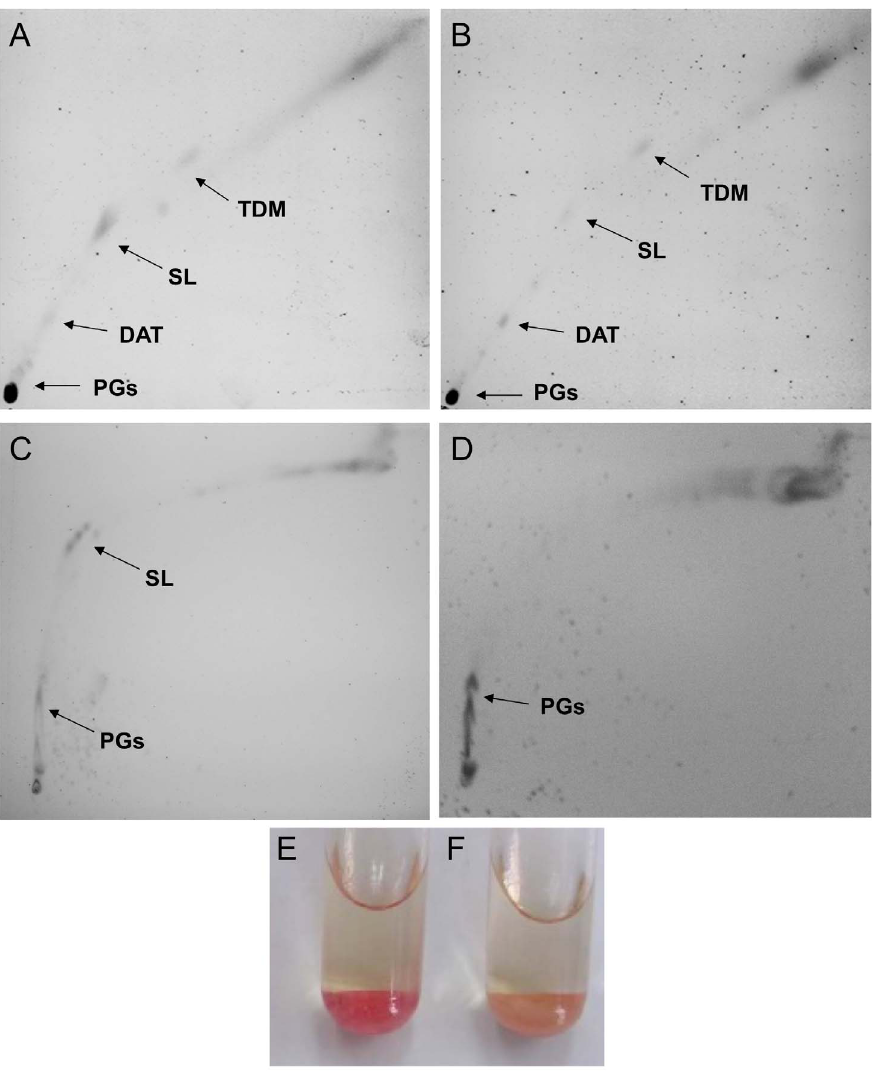
Figure 2. Trehalose-derived glycolipid profile and neutral red staining of M.tuberculosis grown in NRP2 stage. 2D-TLC analysis of Mtb H37Rv grown under oxygen-replete (A and C) and NRP2 (B and D) conditions. Crude extracts were resolved using the two-solvent system: chloroform:methanol:water (60:12:1, v/v) for the first direction and chloroform:methanol:water (75:11:1, v/v) for the second direction. For resolving polar glycolipids (PGs) accumulated in the inoculation point, the elusion time in C and D was prolonged for 30 min after the resolving system reached the edge of the TLC plate. The neutral red staining observed for M. tuberculosis H37Rv cultured in aerobic (E) and NRP2 stages (F) is shown. TDM, trehalose dimycolate; SL, sulfolipid; DAT, diacyltrehalose; PGs, polar glycolipids.